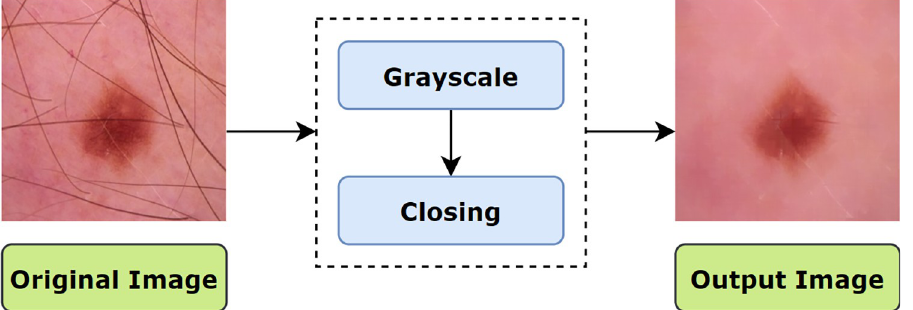
Fig 5. Process flow of applying morphological